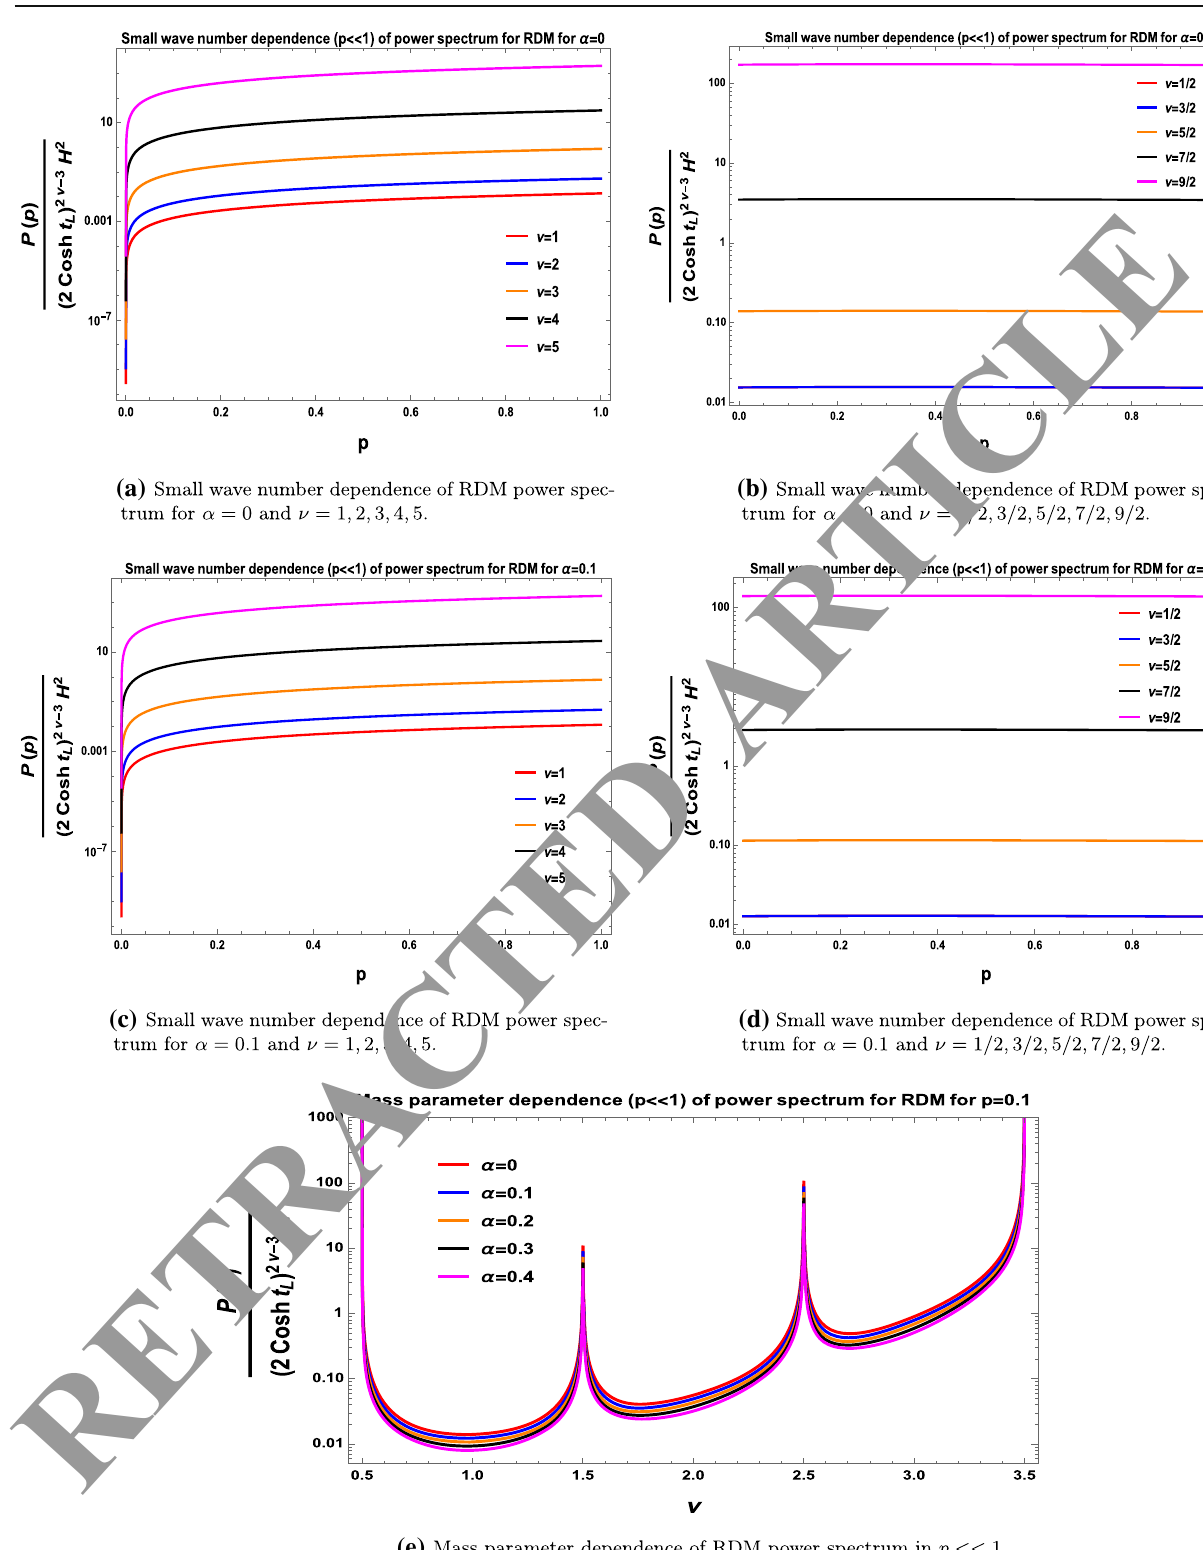
Fig. 10 Features of RDM power spectrum in small wave number